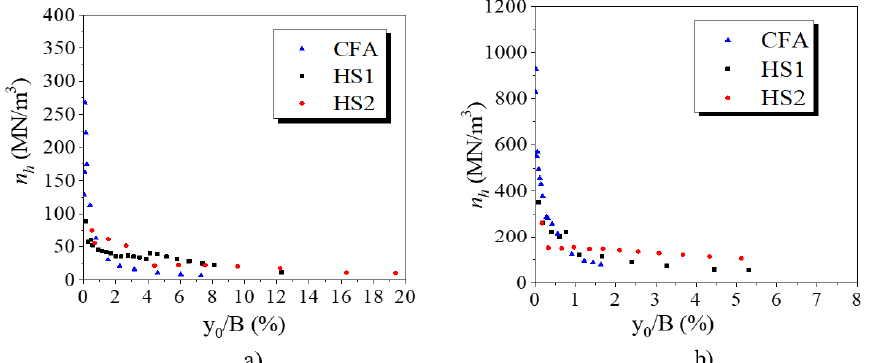
Figure 6. Relationship between the constant of subgrade reaction n h and the horizontal pile displacement at ground level: (a) Area A; (b) Area